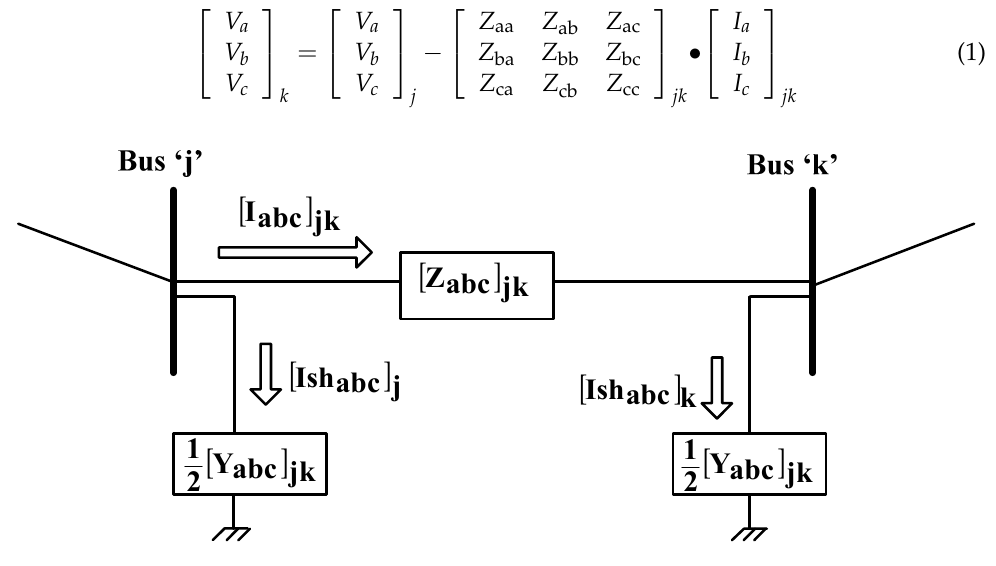
Figure 1 represents the exact three-phase model of power lines. In Equation (1), the phase voltage matrix at bus ‘k’ is expressed with the phase voltage matrix at bus ‘j’ and the phase impedance matrix as well as the phase current matrix for the branch ‘jk’.